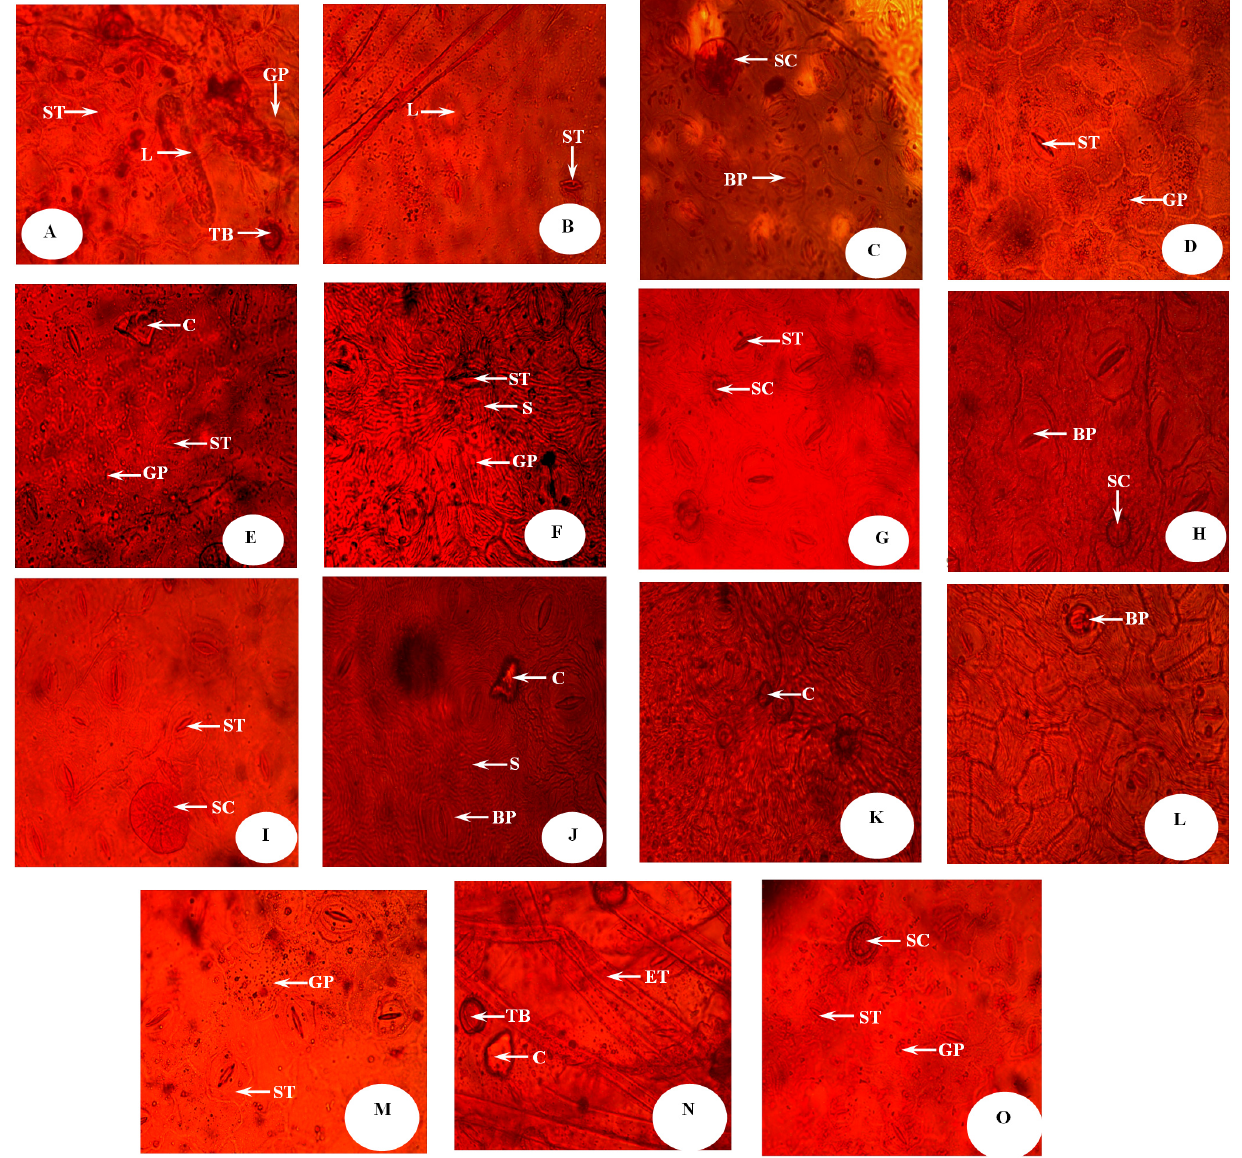
Fig. 2. Abaxial surface of Ipomoea species. A) I. triloba , B) I. eriocarpa , C) I. alba , D) I. hederifolia , E) I. muricata , F) I. intrapilosa , G) I. asarifolia , H) I. batatas , I) I. aquatica , J) I. mauritiana , K) I. carnea , L) I. involucrata , M) I. nil , N) I. heterotricha , O) I. obscura ; BP = Brachyparacytic stoma, SC = Scale, L = Laticifer, ST = Stoma, GP = Granular periclinal wall, C = Crystal, S = Striae, TB = Trichome base, ET = Eglandular trichome, Scale = 0.85